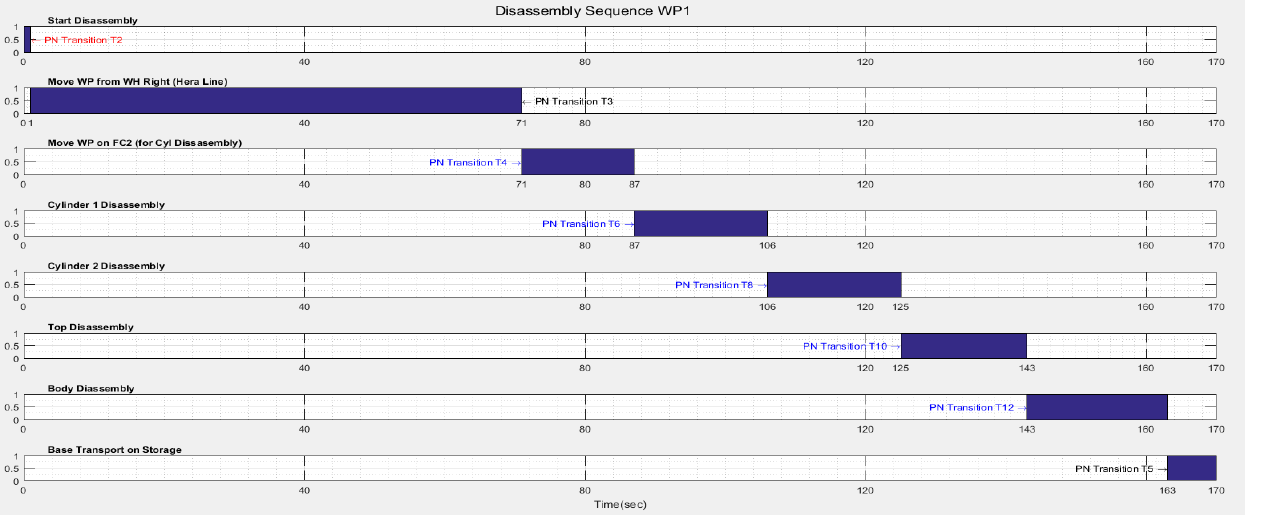
Figure 27. Results for continuous and discrete places associated with displacements of ARS and FC with IRM for Disassembly.